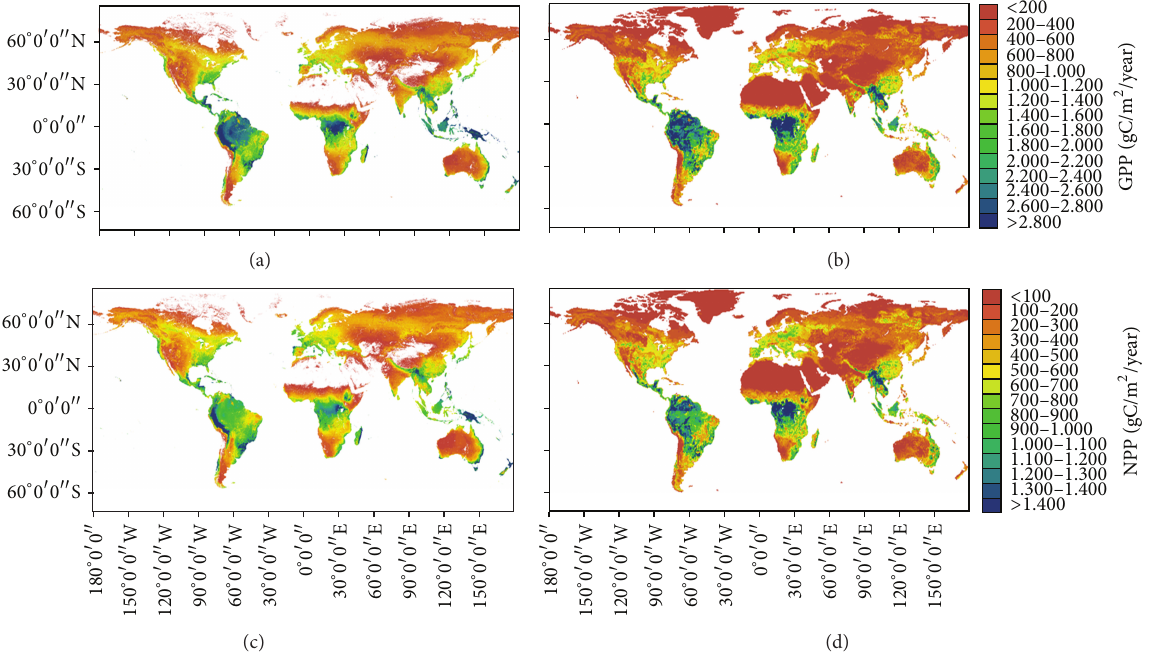
Figure 4: Spatial patterns of MODIS-derived and DLEM-simulated GPP and NPP for year 2010. MODIS-derived GPP (a) and NPP (c) and DLEM-simulated GPP (b) and NPP (d).